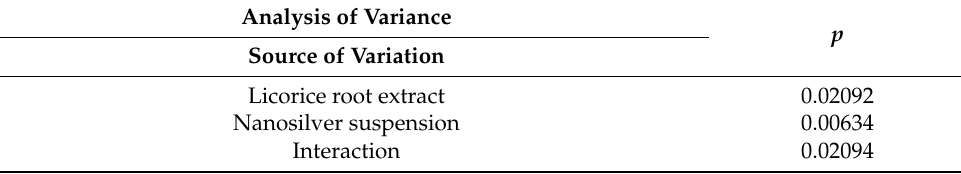
Table 4. Results of the statistical analysis of hydrogels’ percentage elongation measurements per- formed via the two-way analysis of variance (ANOVA) ( p indicates the statistical significance).